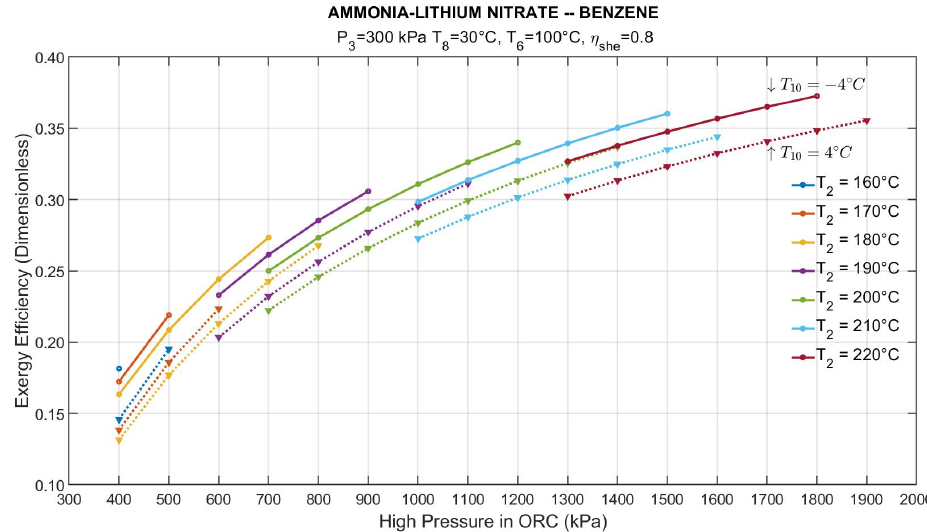
Figure 6. NH 3 -LiNO 3 – C 6 H 6 exergy efficiency as a function of the heat source temperature and the maximum pressure of the ORC.